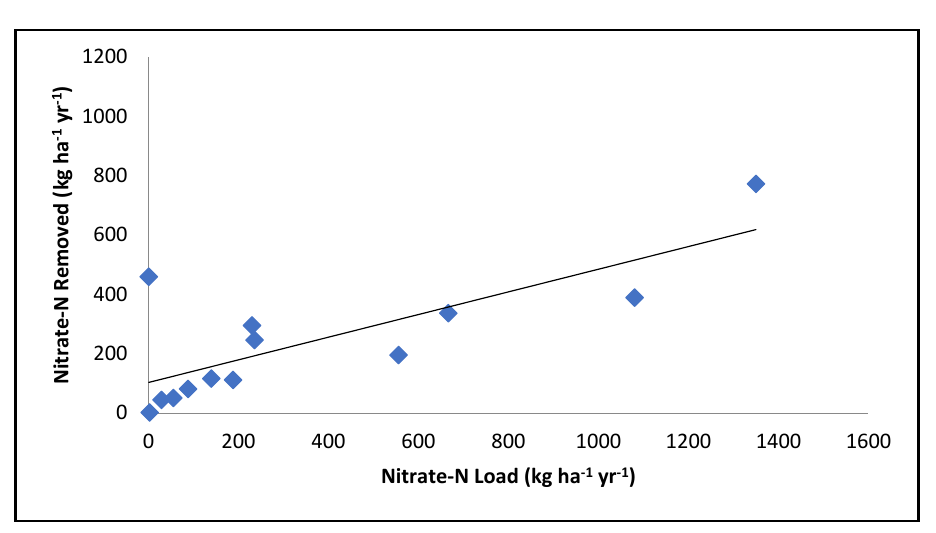
Table 2. Percent removal of nutrients in floodplains. Percent reductions in nitrate-N (NO 3− -N) and total or particulate phosphorus (TP or particulate P) loads in floodplains from literature reviewed.